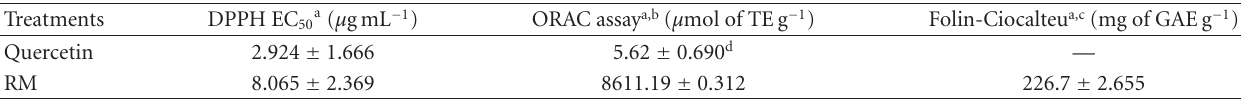
Table 1: RM radical scavenging on DPPH, antioxidant capacity in ORAC-FL assay, and fractions and phenolic compounds content in